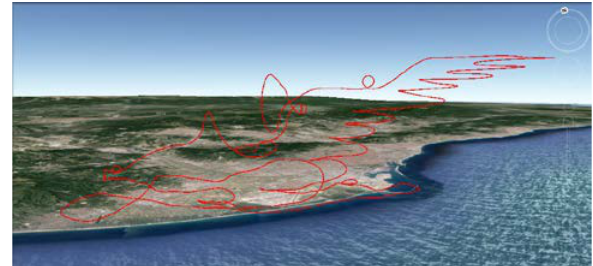
Figure 8: Simulated high-dynamics, aerobatic